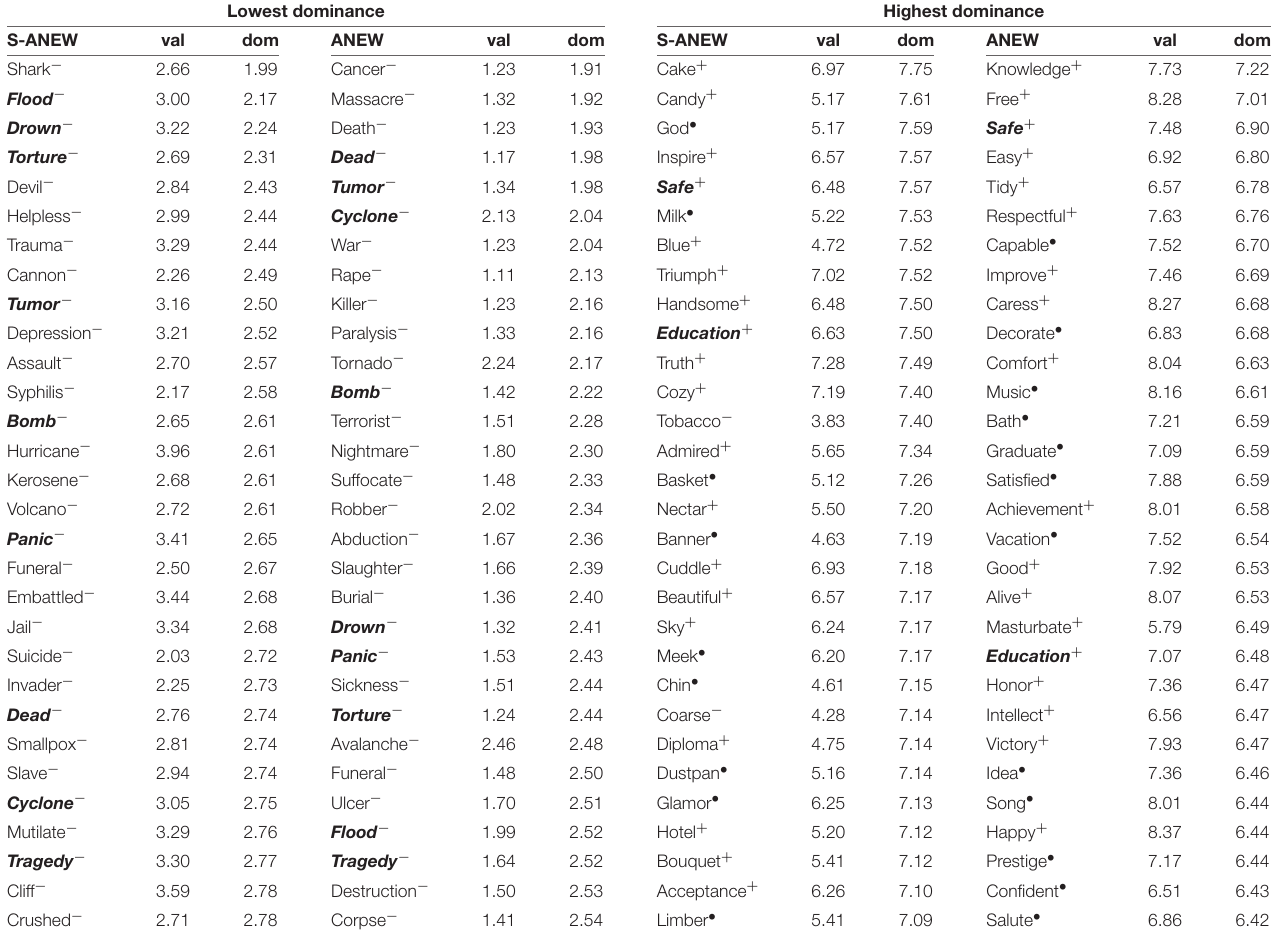
TABLE 6 | The thirty lowest (left) and highest (right) dominance rated words. Lowest dominance Highest